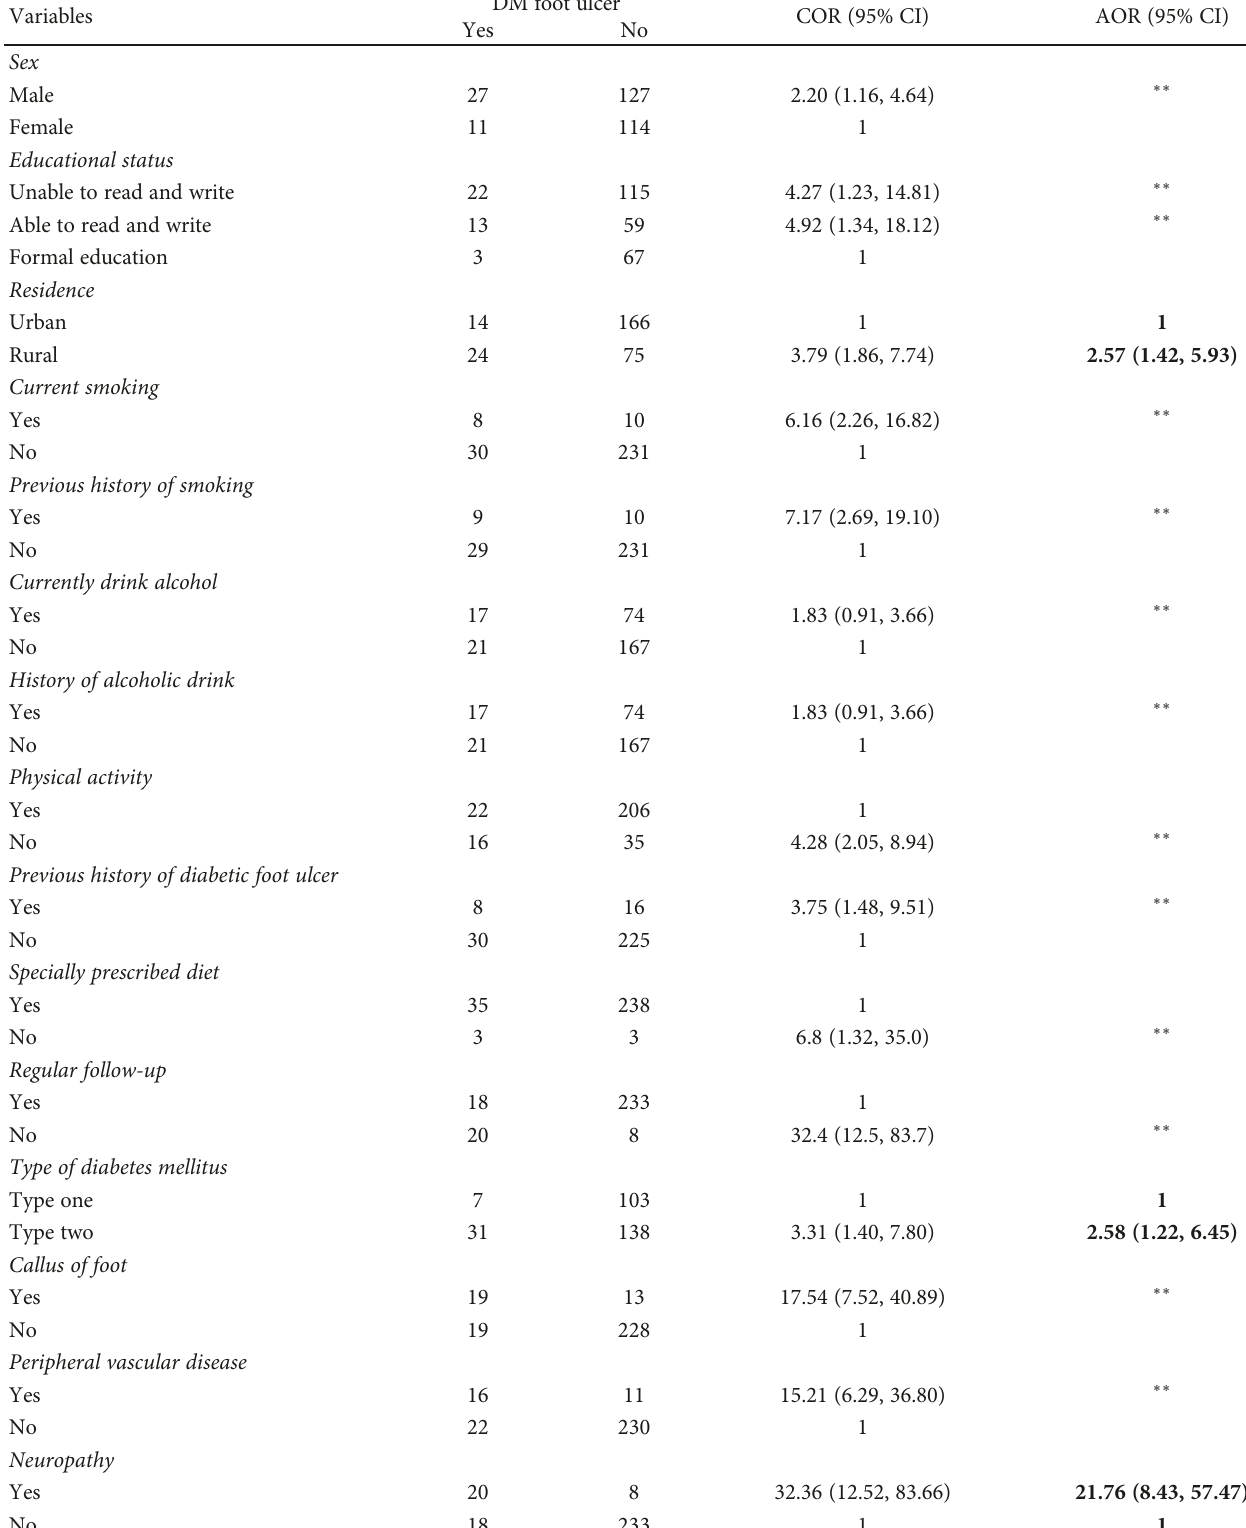
Table 3: Bivariate and multivariate analysis of factors associated with diabetic foot ulcer among adult diabetic patients in Gondar Referral Hospital, Diabetic Clinic, 2016 ( n = 279